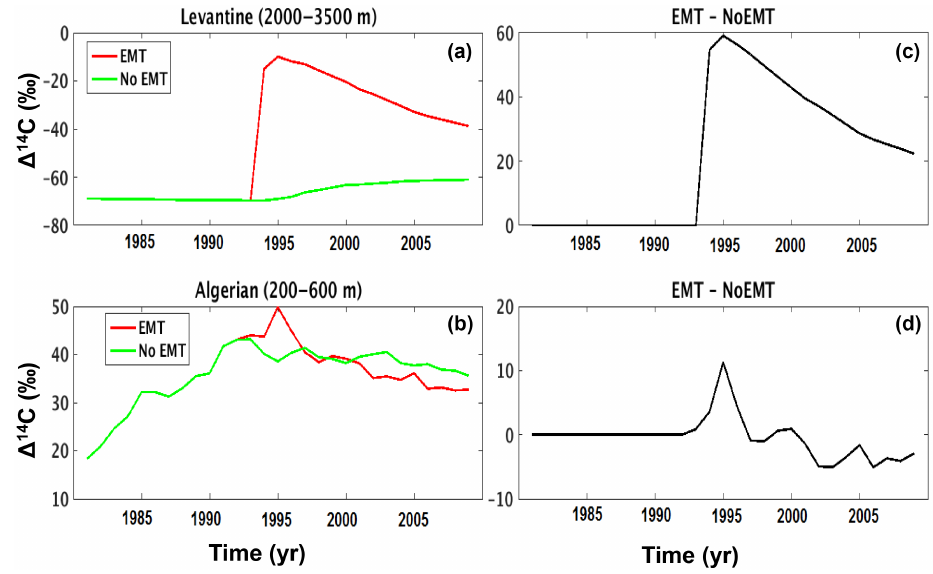
Figure 11. Mean (cid:49) 14 C obtained for experiment with EMT (red) and NoEMT (green) (a) in the Levantine sub-basin deep water (2000– 3500m depth) and (b) in the Algerian sub-basin at intermediate level (200–600m). The right panels illustrate the difference between EMT and NoEMT for the corresponding left